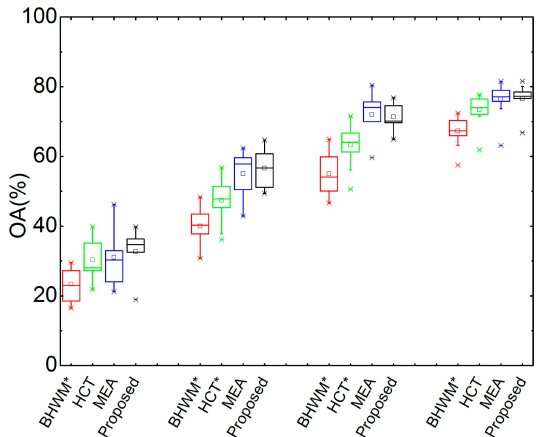
Figure 5. OAs of compared methods on Bach10 (%).